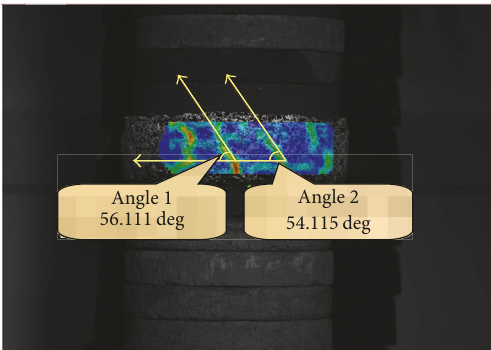
Figure 10: Break angles of the mudded weak interlayer specimen under uniaxial